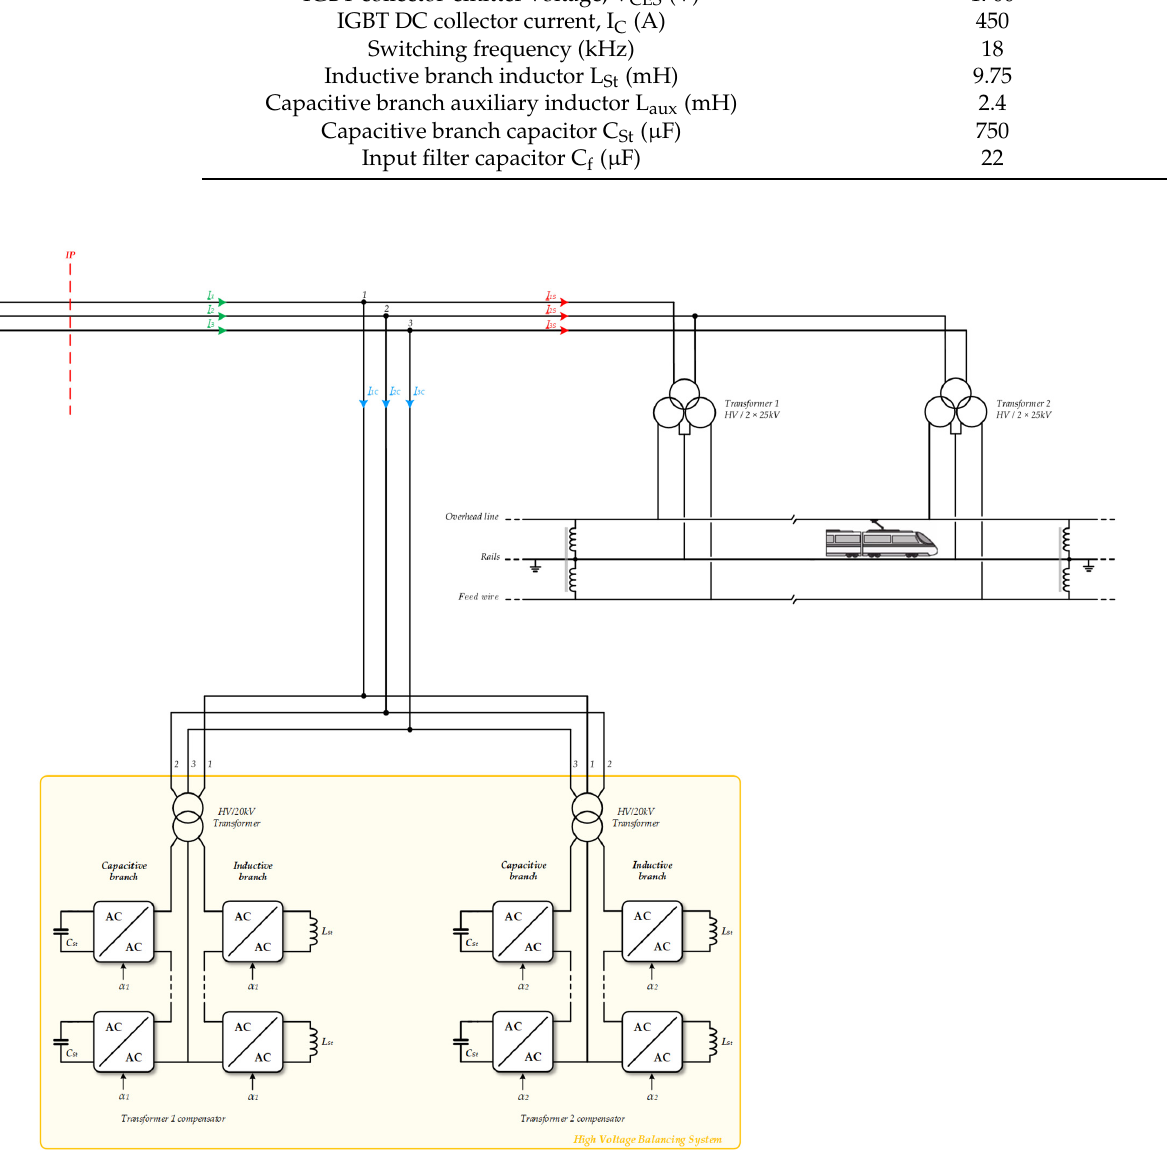
Figure 9. Implementation of the High Voltage Balancing System in a substation with a V-connection scheme.